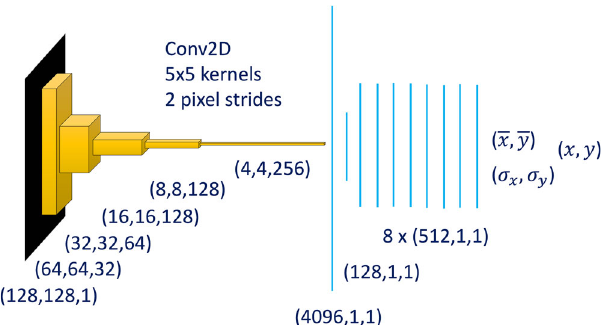
Fig. 2 Architecture of encoder half of VAE. The decoder is the same model structure in